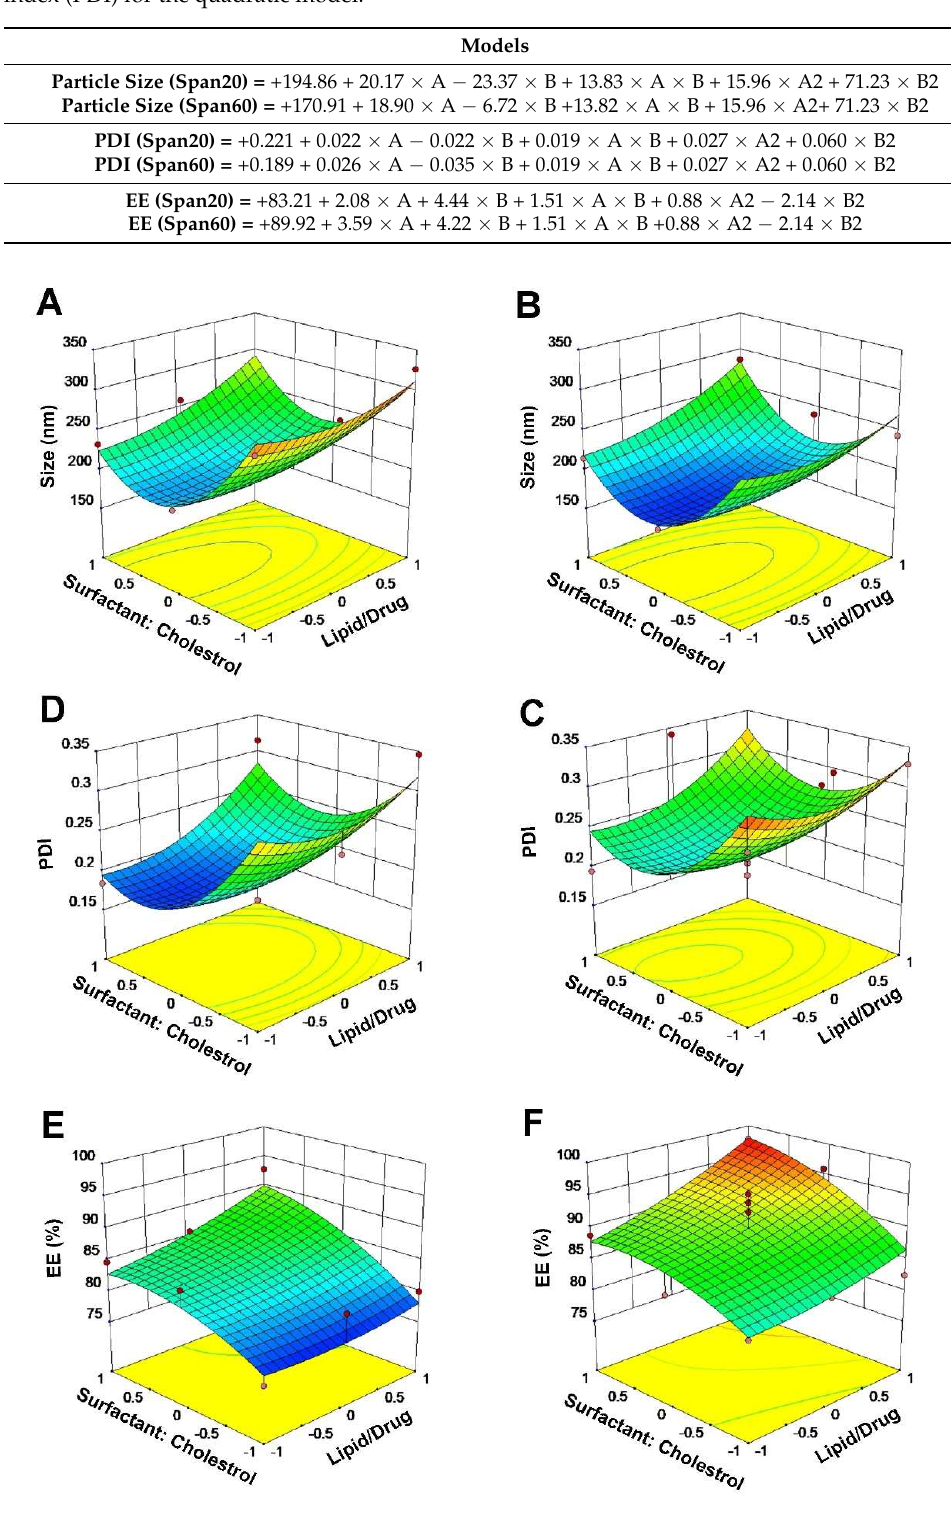
Figure 1. Effects of different variables on size of niosomes, polydispersity index of niosomes and entrapment efficiency of drug by niosomes when Span 20 ( A , C , E ) and Span 60 ( B , D , F ) were used in the formulation.